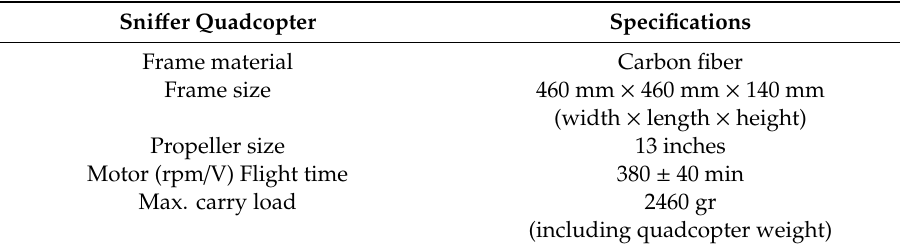
Table 1. Detail specifications of sni ff er